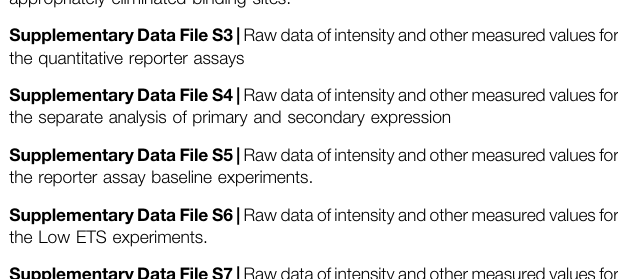
Supplementary Table S4 | Pairwise comparisons using t-tests with pooled SD for data of separated analysis of mutation constructs with primary and secondary notochord. Above, primary notochord. Below, secondary notochord. Red p -value < 0.05. Supplementary Table S5 | Pairwise comparisons using t-tests with pooled SD for data of comparison of primary/secondary ratio of intensity. Red p -value < 0.05. Supplementary Table S6 | Pairwise comparisons using t-tests with pooled SD for data of Separated analysis of ETS and low ETS constructs with primary and secondary notochord. Above, primary notochord. Middle, secondary notochord. Below, primary/secondary ratio of intensity. Red p -value < 0.05. SupplementaryTableS7| The major difference between wildtype and Low ETS mutation constructs. Above to below, ETS, RBPJ, FOSB:JUN, FOXA1, ZIC1 and T sites. Left, wild type. Right, Low ETS. Gray, appropriately eliminated sites on Low ETS construct. Blue, the score was decreased but not completely eliminated sites on Low ETS construct. Pink, accidentally eliminated sites on Low ETS construct. Yellow, accidentally score increased sites on Low ETS construct. Supplementary Table S8 | Details of individual TFBS